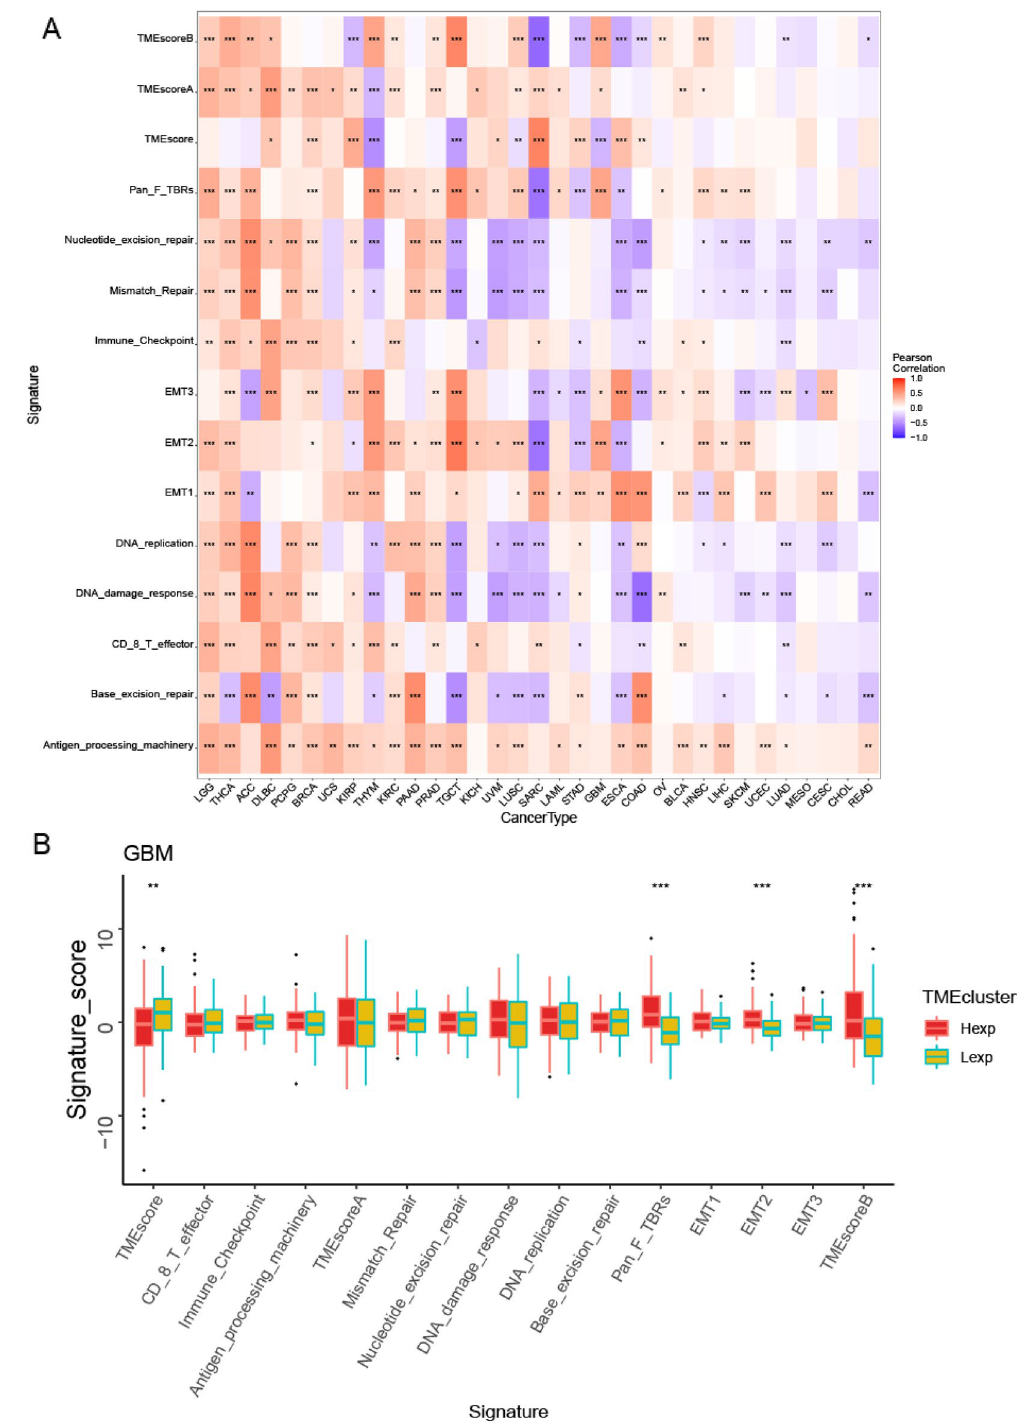
Figure 6. SLC35C1 expression is correlated with the TME. ( A ) Correlation between the expression of SLC35C1 and 15 TME processes. Red denotes a correlation coefficient > 0, whereas blue denotes a correlation coefficient < 0. ( B ) The statistical chart after using the CIBERSORT method shows the proportion difference of TME between SLC35C1 high and low expression groups in glioma. Red represents the high SLC35C1 expression group, yellow represents the low SLC35C1 expression group. *P < 0.05; **P < 0.01; ***P < 0.001. ns, no